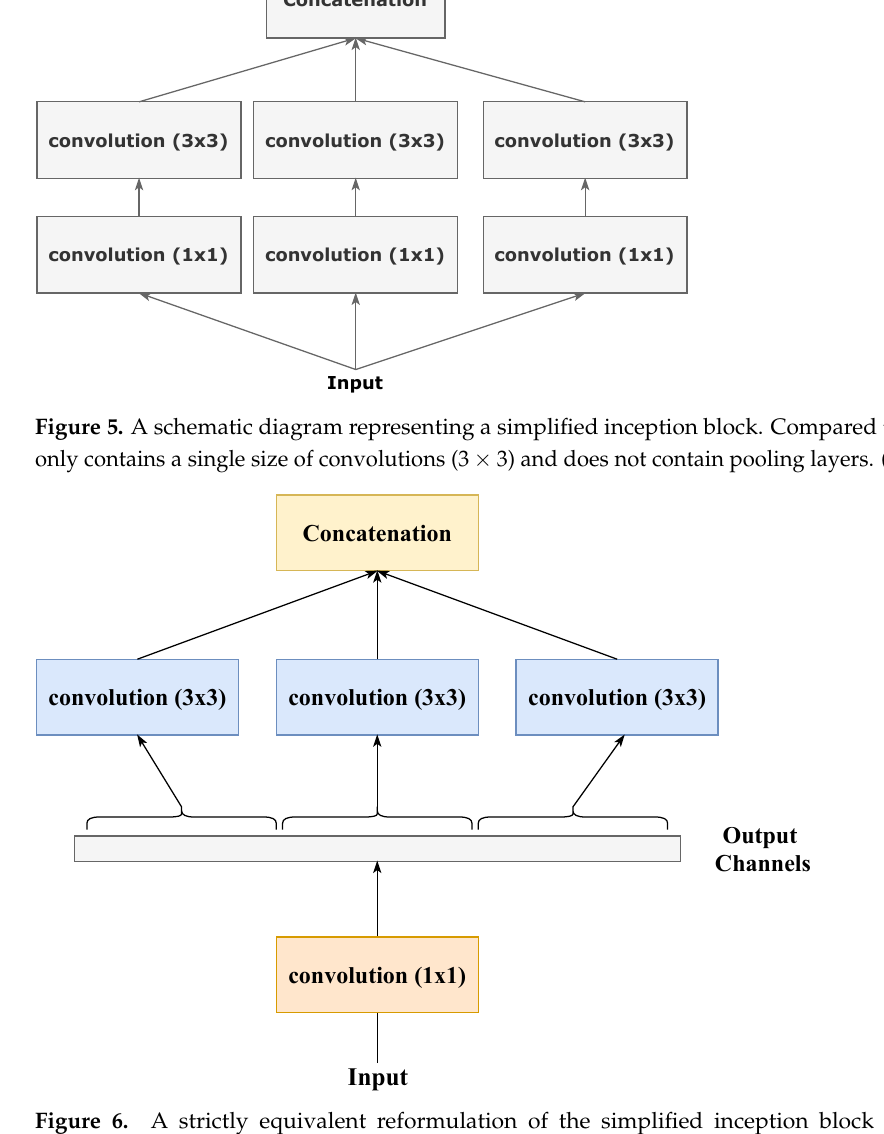
Figure 6. A strictly equivalent reformulation of the simplified inception block of Figure 5. Chollet